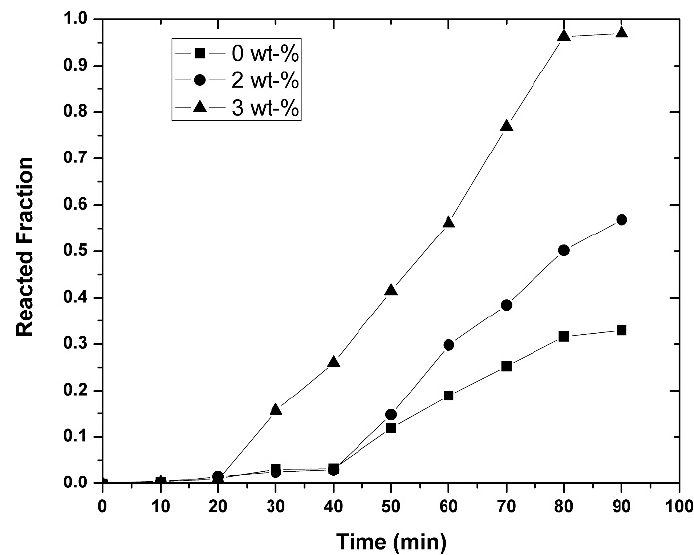
Figure 13. Reacted fraction of Ni as a function of time for the initial magnesium concentrations indicated, at the constant temperature of 1123 K, and constant agitation speed of 300 rpm.